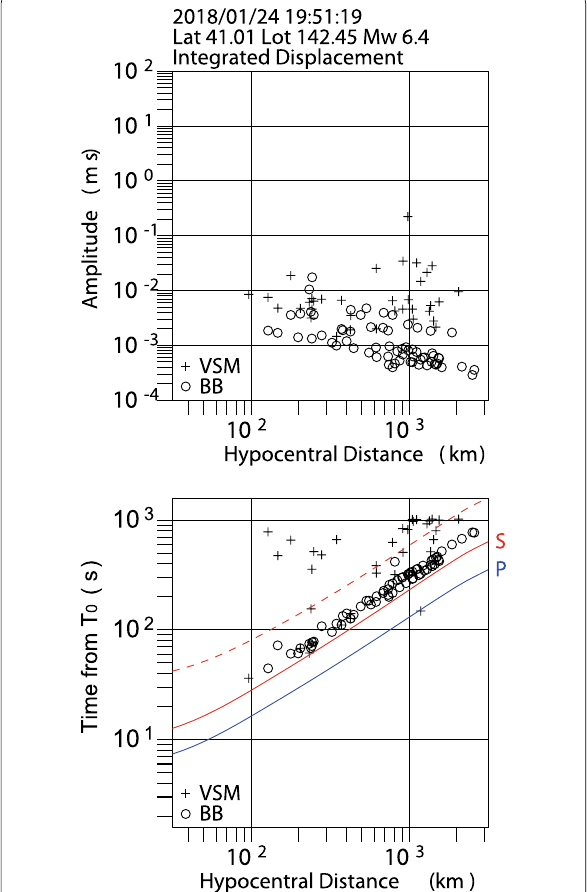
Fig. 3 Peak amplitudes of integrated displacement (upper) for an earthquake that occurred on 24 January 2018 ( M w 6.4), and travel times to peak amplitude (lower) in relation to hypocentral distance for amplitudes observed with velocity-type strong-motion (VSM) seismometers (crosses) and broadband (BB) seismometers (circles). The solid blue, solid red, and dashed red curves show the calculated values of T 0 + T P , T 0 + T S , and T 0 + 2.5 T S + T D , respectively, where T 0 is origin time, T P is P -wave travel time, T S is S -wave travel time, and T